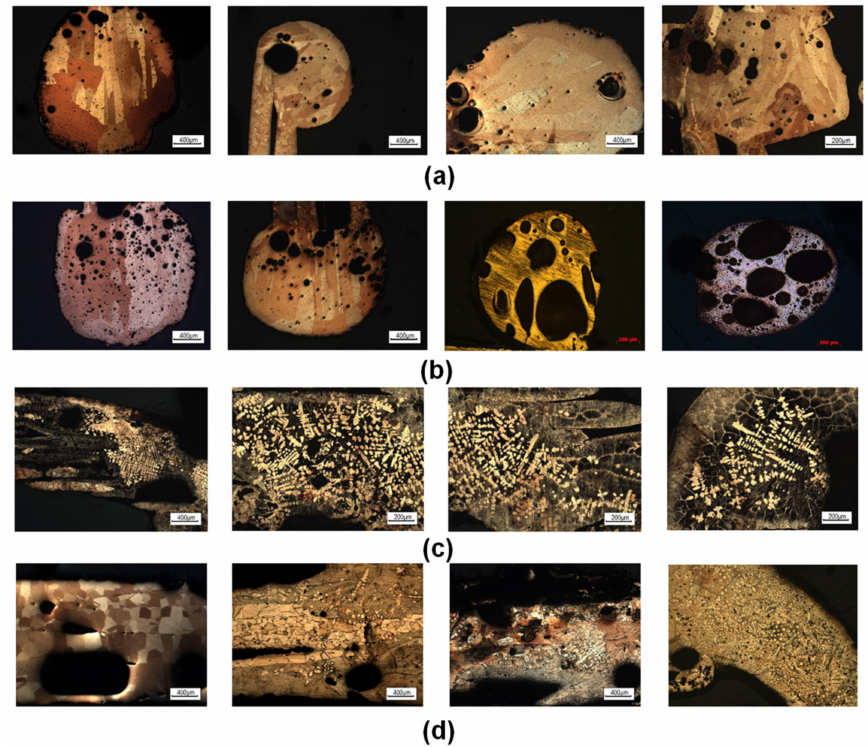
Figure 1. Examples of metallurgical micrographs used for parameters extraction and classification. Micrographs shown in ( a – d ) are cross-sectional views of CB, VB, OG and FG